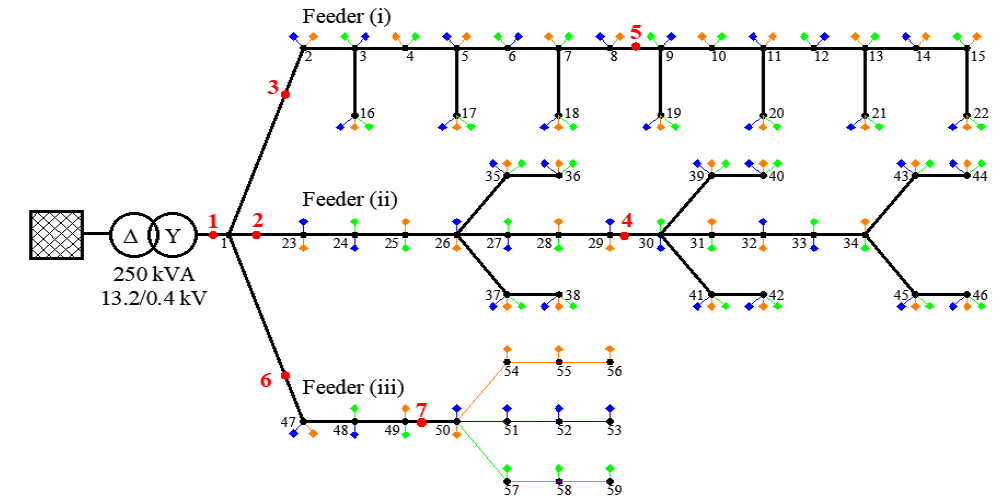
Figure 1. Topology of the synthetic Low Voltage (LV) distribution network.